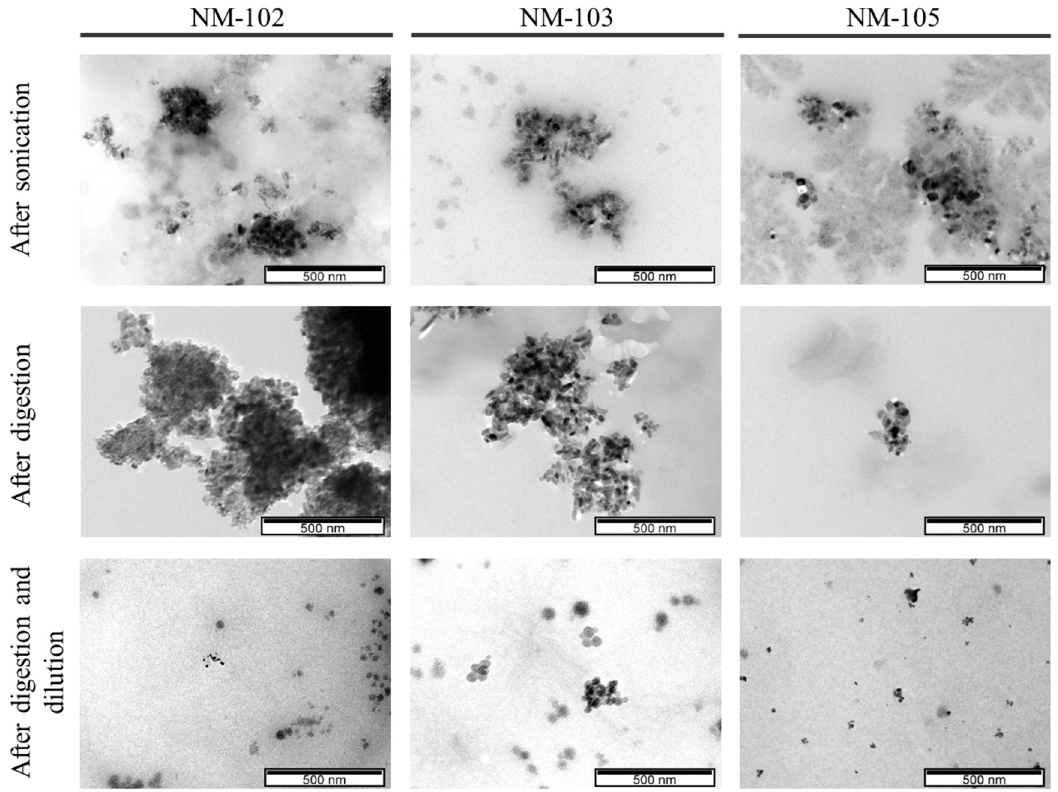
Figure 1. TiO 2 observed under electron microscopy, at a scale of 500 nm.